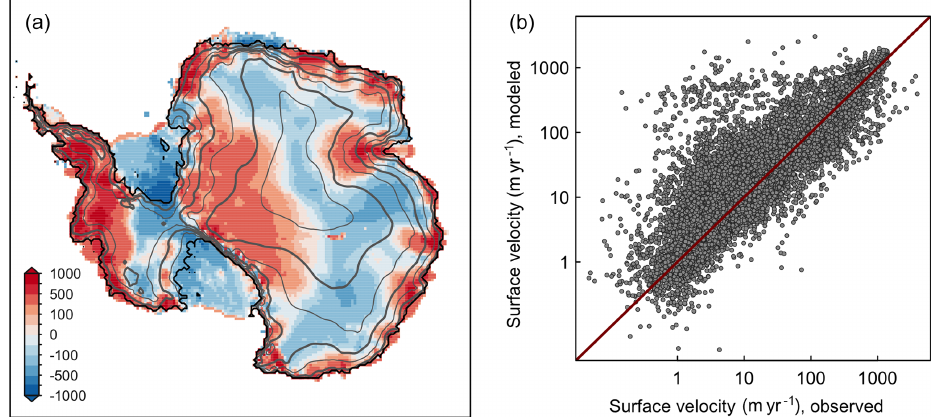
Figure 11. (a) Simulated present-day ice-thickness minus observations and (b) simulated versus observed ice surface velocity. The colors in (a) show the ice thickness difference in meters, and the dark grey contours show surface elevation in 500m intervals (thick lines correspond to 1000, 2000 and 3000m above sea level). The black line shows the grounding-line position. In (b) , the dark red line indicates a perfect correlation between model and